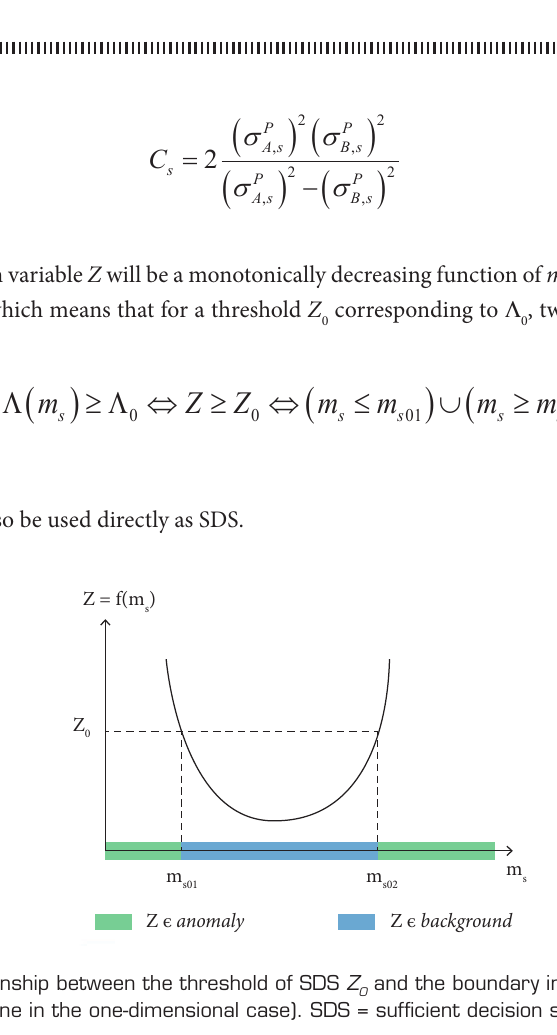
in one case and a monotonically s corresponding to Λ , two thresholds m and m will be 0 0 s 01 s 02